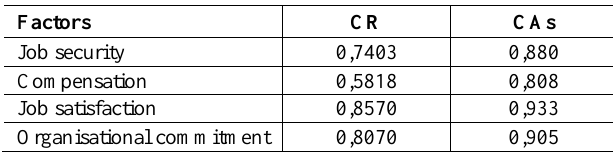
Table 5: Construct reliability estimates and